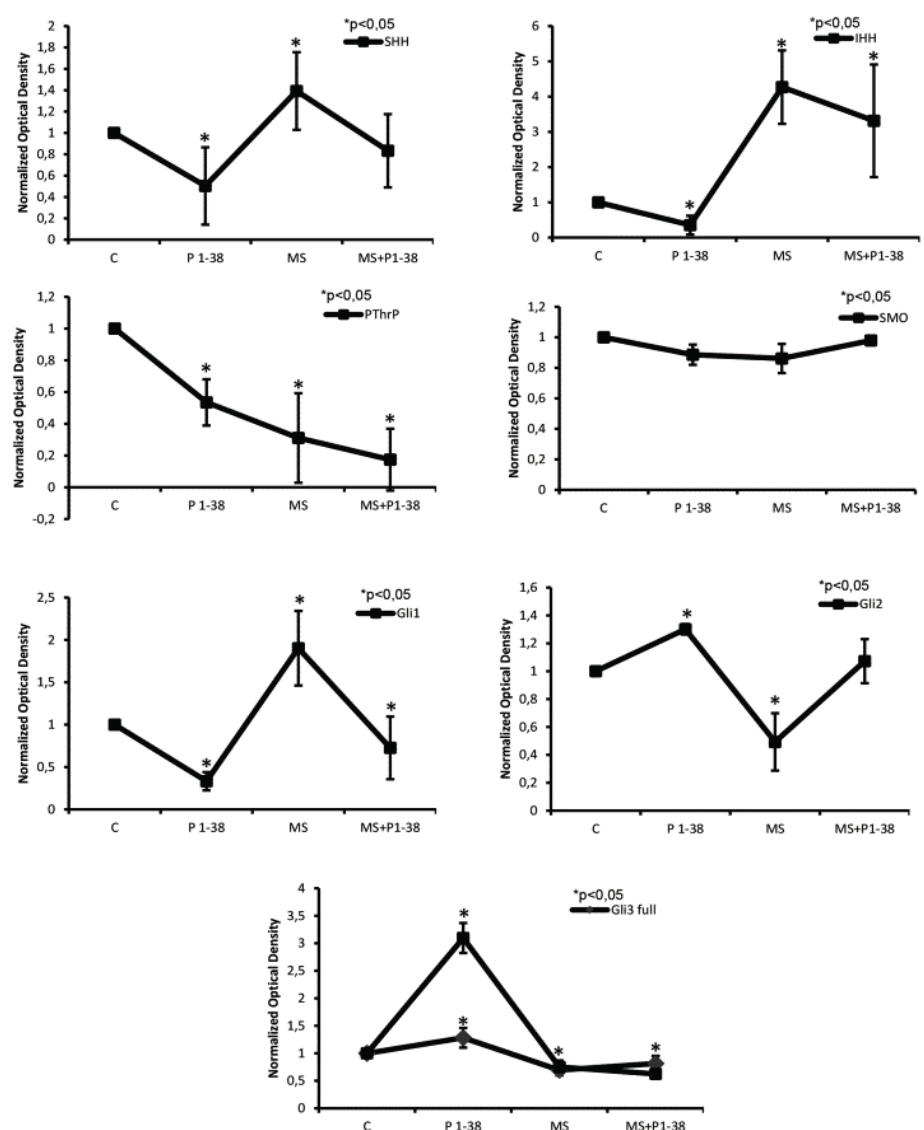
Figure 4. Effects of PACAP and/or mechanical stimulus on HH signaling of chondrofying cells. mRNA ( A ) and protein ( C ) expression of IHH, PTHrP, SHH, Smoothened (Smo), Gli1, Gli2 and Gli3 in HDC cultures on day three of culturing. For RT-PCR ( A ) reactions GAPDH and for Western blot ( C ) reactions Actin was used as control. Optical density of signals was measured and results were normalized to the optical density of controls. For panels ( A , C ) numbers below signals represent integrated densities of signals determined by ImageJ software. Representative results of three independent experiments are shown; ( B , D ) Statistical analysis of RT-PCR and Western blot data. All data are the average of at least three different experiments. Asterisks indicate significant (* p < 0.05) alteration of expression as compared to the respective control in all panels. Statistical analysis was performed by Student’s t -test. All data were normalized on GAPDH/Actin and data are expressed as mean ± SEM. (C, control; P1–38, PACAP 1–38; MS; mechanical